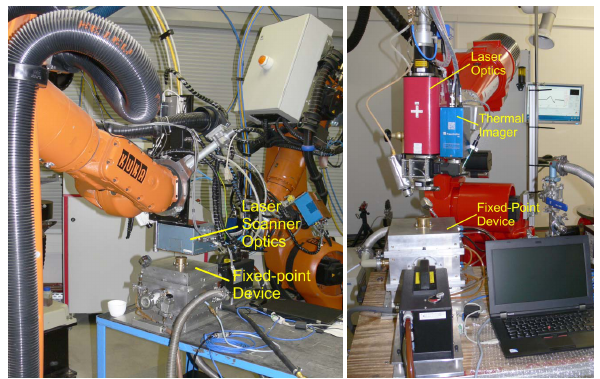
Figure 8. Prototype of the induction-heated fixed-point device, and set-ups for on-site calibration of laser processing heads mounted on industrial robot systems. Left: calibration of scanner optics with an integrated thermal imaging system at a machine for industrial laser hardening of steam turbine blades (Fraunhofer IWS Dresden, Germany). Right: calibration of zoom optics with variable laser beam width at a machine for job-shop laser hardening (ALOtec Dresden GmbH, Germany).